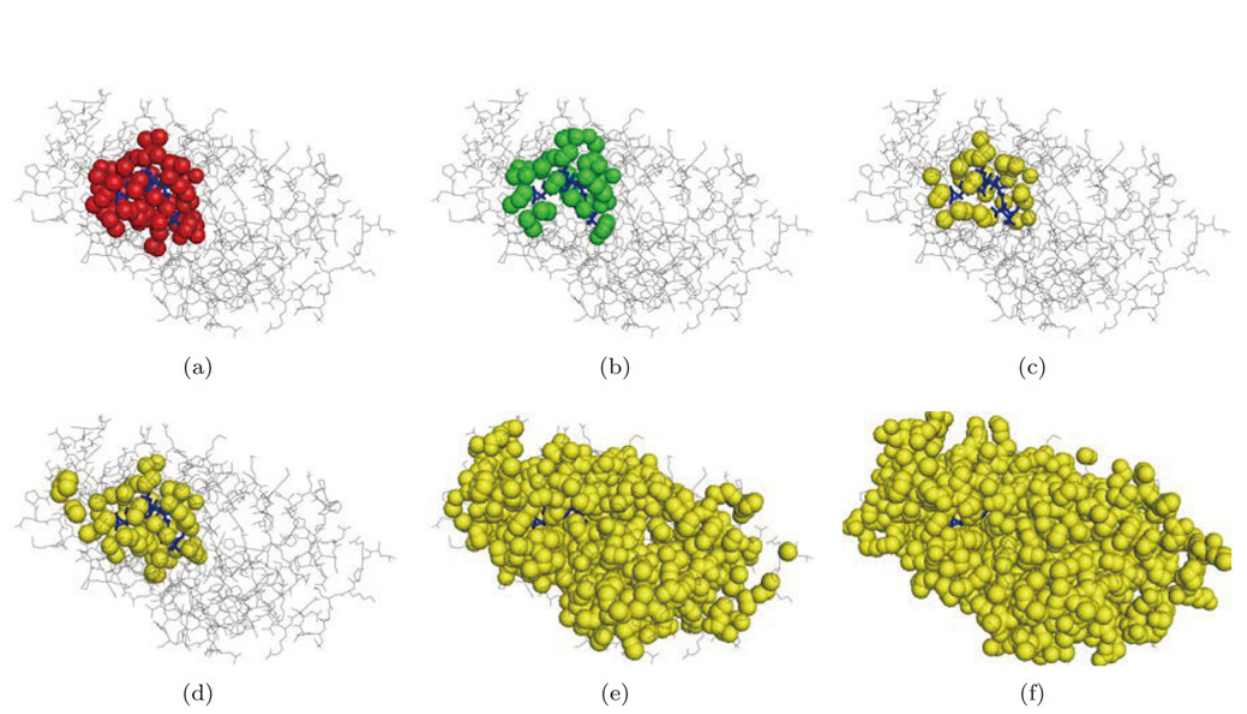
Fig 17. The visualization of pocket (PDB accession code: 1s19). (a) The optimal pocket, (b) the best matched component produced by the proposed method, (c), (d), (e), and (f) are the atoms recognized by the STP method for the threshold values 80, 60, 40, and 20, respectively.